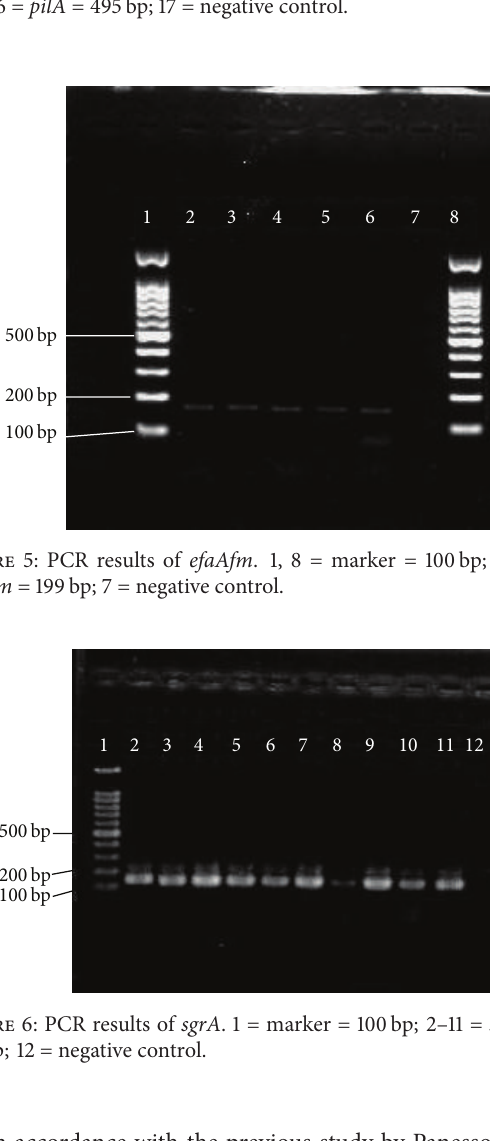
Figure 6: PCR results of sgrA . 1 = marker = 100bp; 2–11 = sgrA = 150 bp; 12 = negative